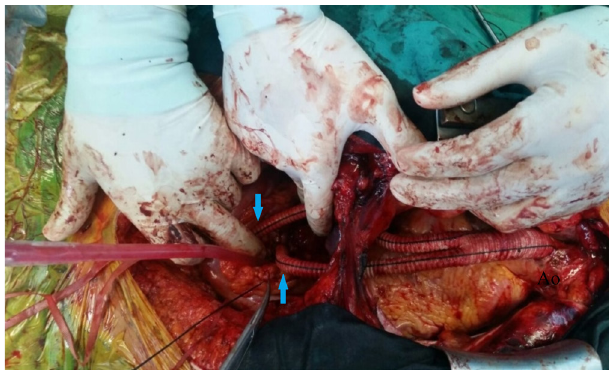
Fig. 4 - Vascular Y-graft from ascending aorta to superior mesenteric artery and celiac artery after